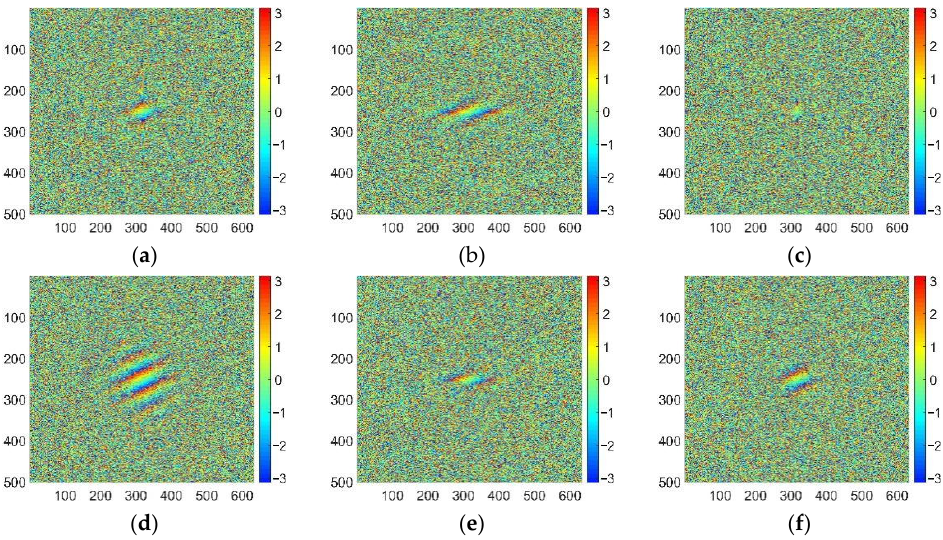
Figure 9. The cross-power spectrum corresponding to the simulated data, where ( a , d ) are iron tex- tures, ( b , e ) are cement textures, and ( c , f ) are soil textures. textures, ( b , e ) are cement textures, and ( c , f ) are soil